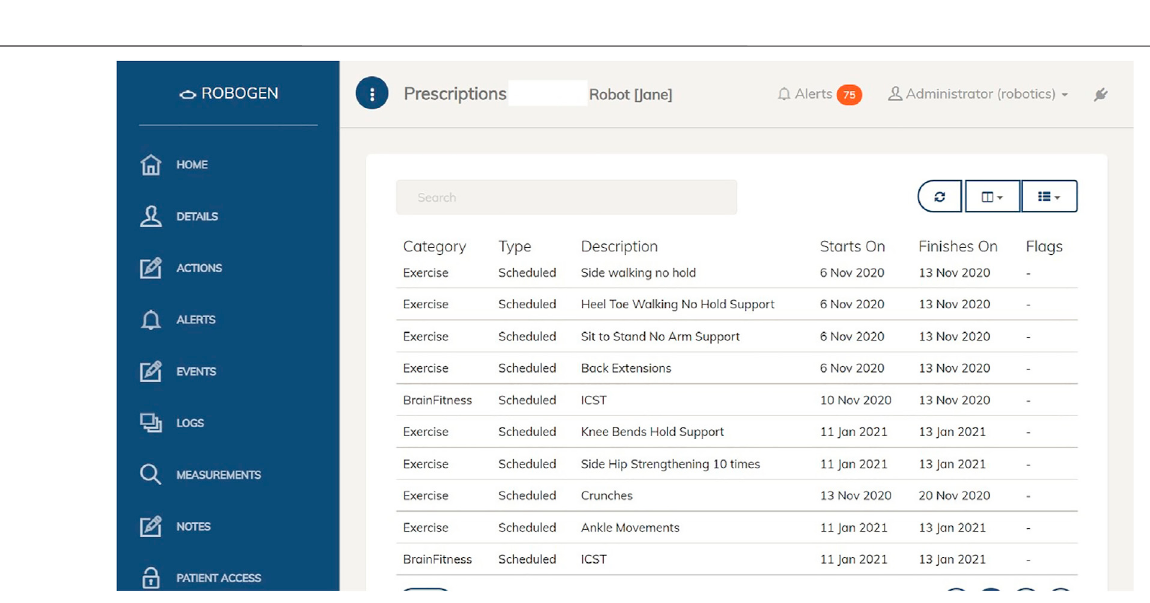
Frontiers in Robotics and AI |